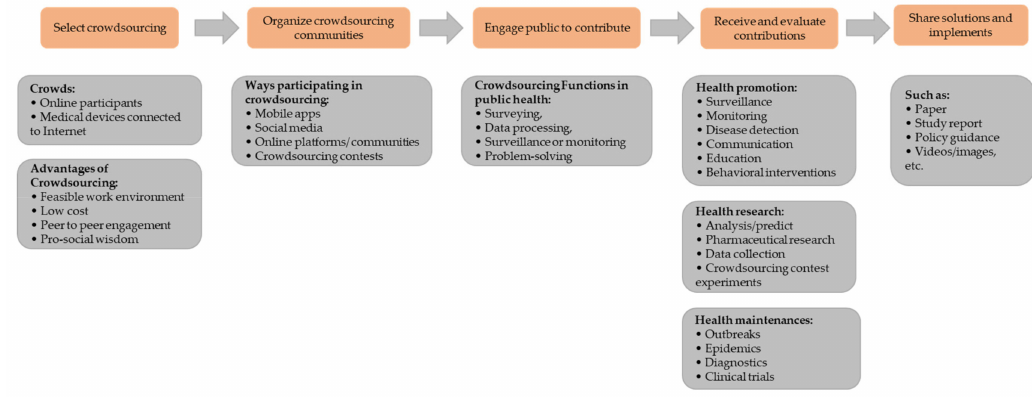
Figure 1. The application process of crowdsourcing in the public health